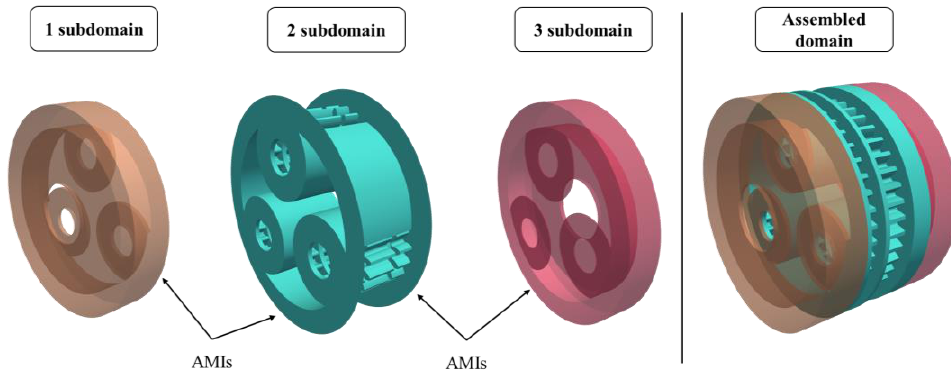
Figure 2. Domain decomposition: the AMIs enable the numerical connection among the 3 subdo- mains.